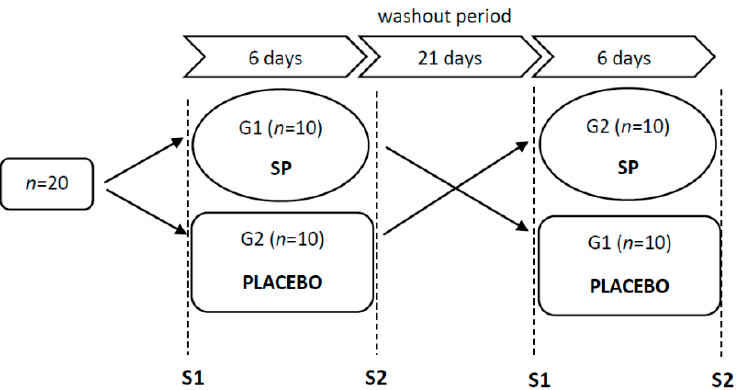
Figure 1. Study design. SP—sodium phosphate supplementation (50 mg/kg FFM per day); S1 and S2—two test series, before and after each supplementation phase.